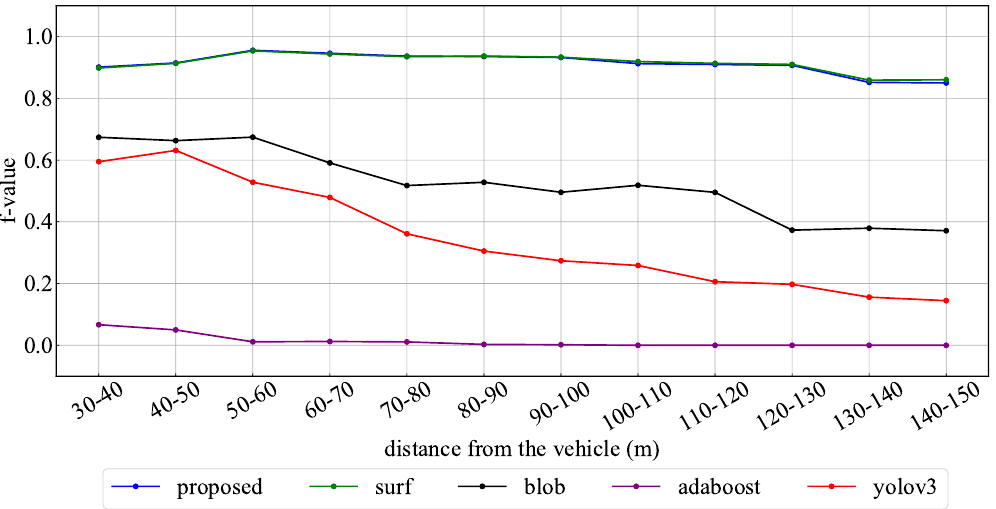
Figure 17. F values for dark data: different candidate extraction methods.